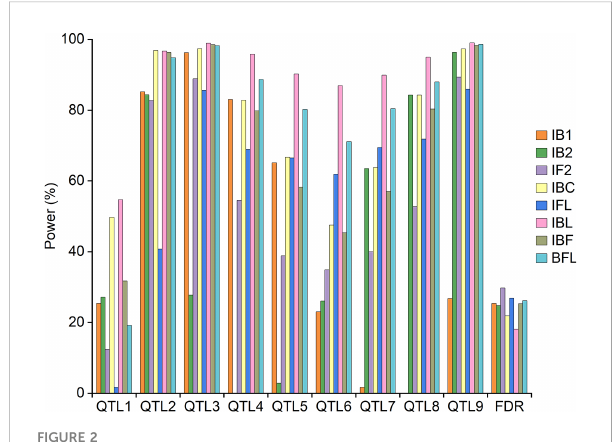
FIGURE 2 QTL detection power from individual and combined mappings in simulation experiment